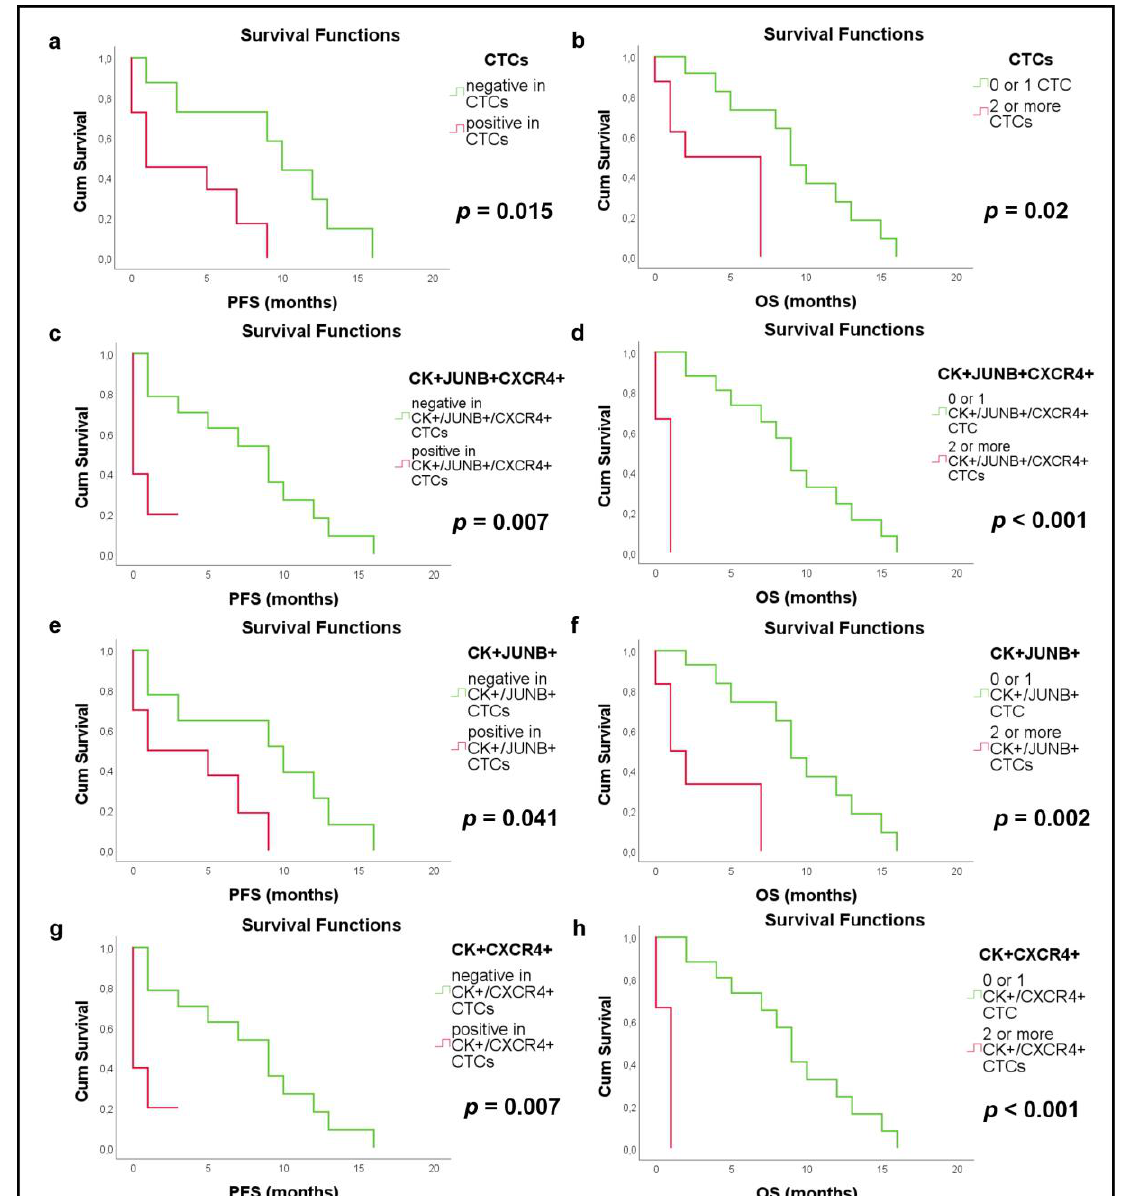
Figure 3. Kaplan – Meier survival curves in NSCLC patients related to CTCs and specific pheno- types. ( a ) Progression free survival (PFS) for detection of at least one CTC ( p = 0.015, HR = 4.46) ( b ) Overall survival (OS) for detection of at least two CTC ( p = 0.02, HR = 4.94) ( c ) PFS for detection of the (CK+/JUNB+/CXCR4+) phenotype ( p = 0.007, HR = 5.21) ( d ) OS for detection at least two (CK+/JUNB+/CXCR4+) CTCs ( p < 0.001, HR = 2.16) ( e ) PFS for identification of (CK+/JUNB+)